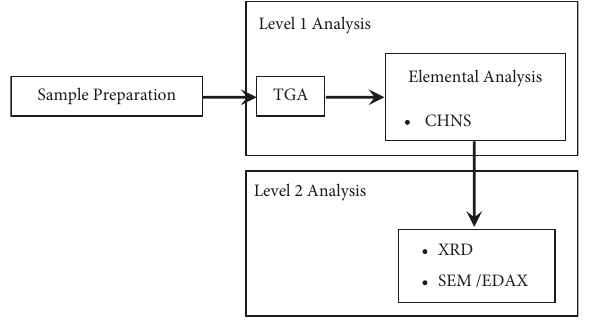
Figure 5: Fouling deposit analysis sequence. Table 3: TGA results for hard deposits.